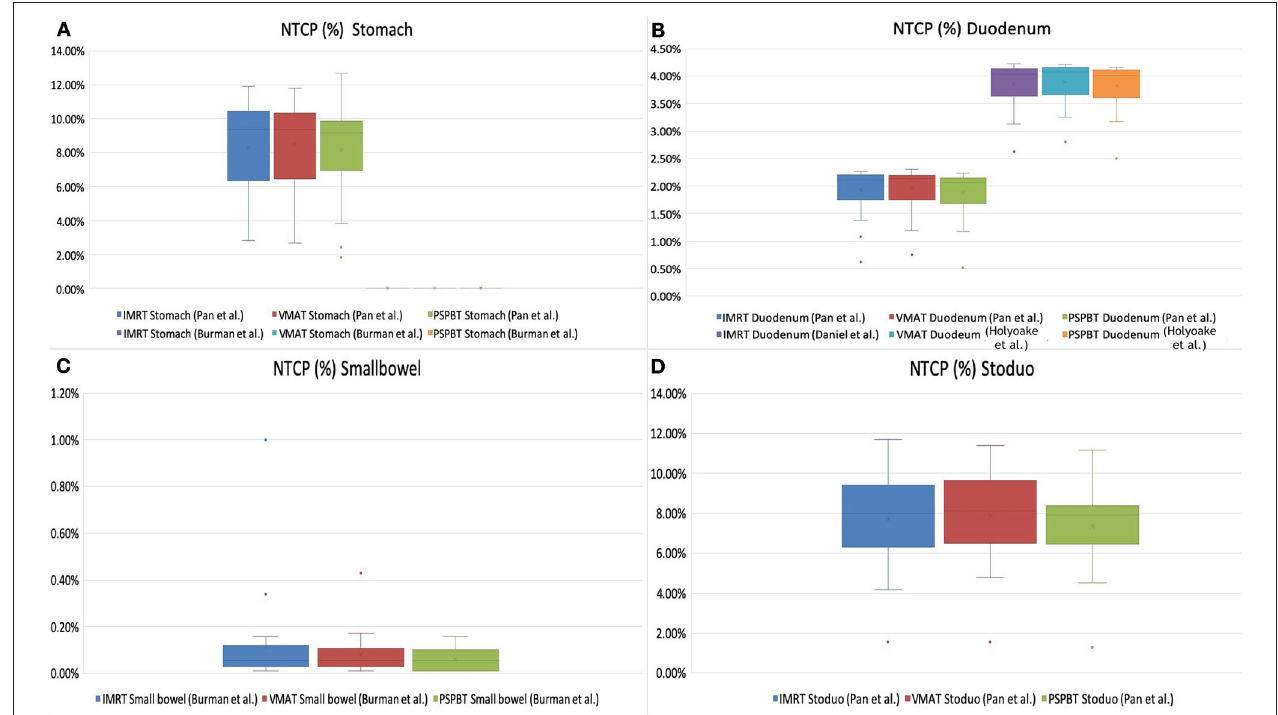
FIGURE 4 | Normal tissue complication probability (NTCP, in percent) of gastrointestinal organs at risk (OARs) [stomach (A) , duodenum (B) , small bowel (C) , and stoduo (D) ] for intensity-modulated radiotherapy (IMRT), volume-modulated arc therapy (VMAT), and 3D-passive scattering proton beam therapy (3D-PSPBT) calculated using Lyman–Kutcher–Burman (LKB) model parameters from Pan et al., Burman et al., and Holyoake et al. (graph: NTCP% is plotted along the Y -axis).